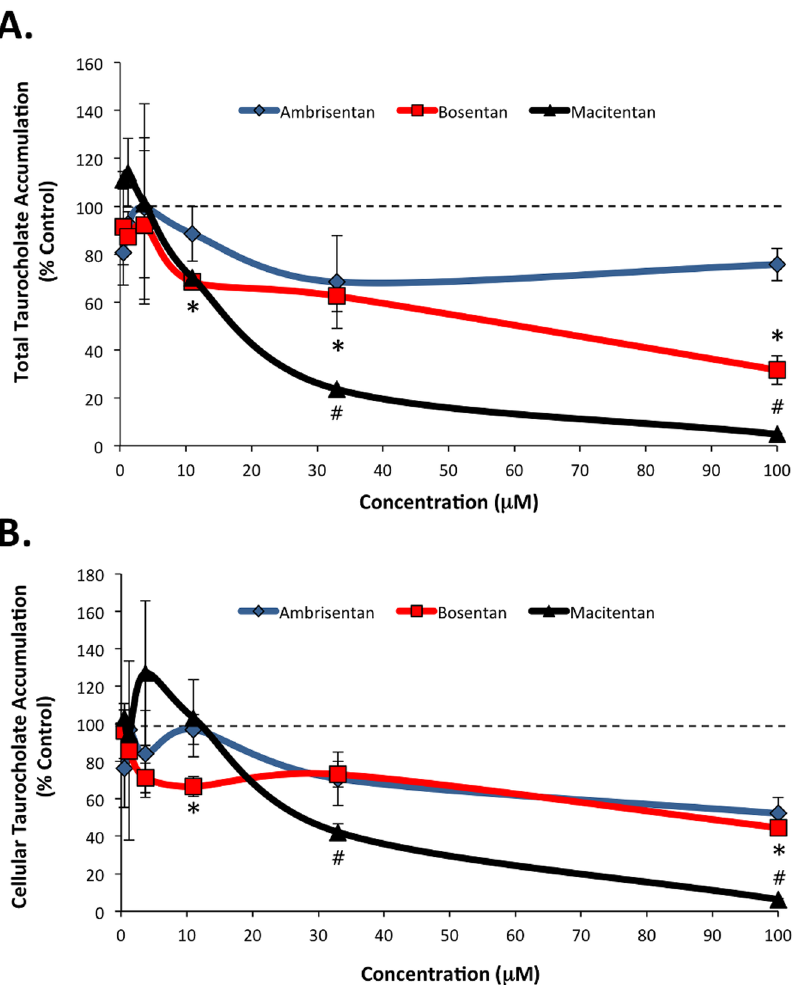
Figure 2. d 8 -Taurocholate (d 8 -TCA) total (A) and cellular (B) accumulation in sandwich-cultured human hepatocytes exposed to ambrisentan, bosentan and macitentan. Bosentan and macitentan treatment resulted in a dose-dependent reduction in total accumulation of d 8 -TCA. Ambrisentan, bosentan and macitentan treatment each resulted in a dose-dependent reduction in cellular accumulation of d 8 -TCA. Data presented as mean ( 6 SD) expressed as percent of control treated; n=3 donors; *P , 0.05 bosentan vs. control; # P , 0.05 macitentan vs. control.